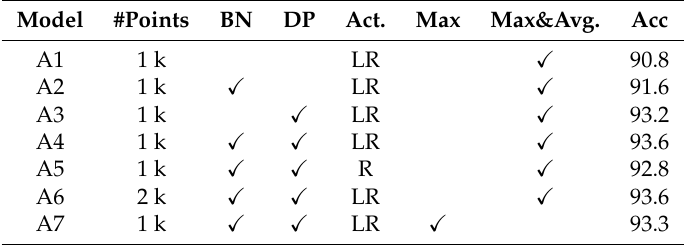
Table 6. Ablation study of AttPNet on ModelNet40 dataset. “BN” denotes batch norm layers [36]. “DP” represents dropout layers. “Act.” indicates activation layers. “max&avg.” means that we combine the results from two aggregation functions. Model A4 corresponds to AttPNet.